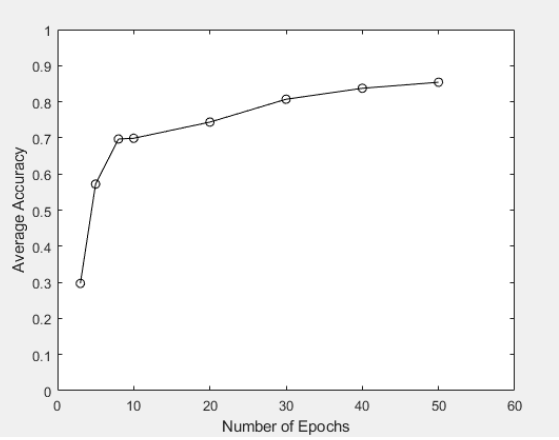
Figure 13. Average recognition accuracy versus the number of epochs used in the